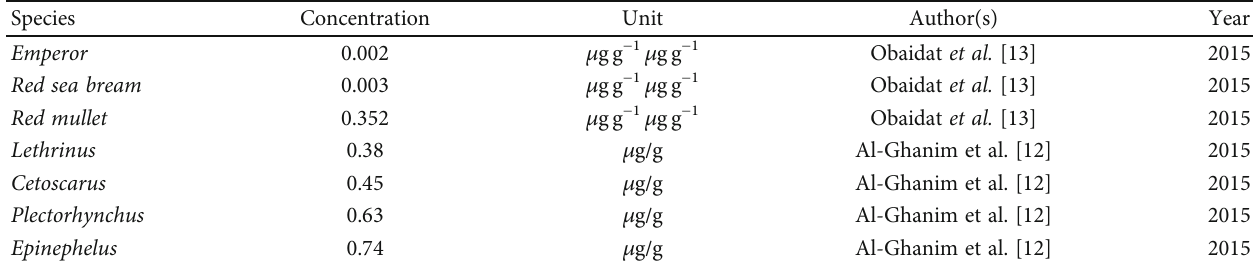
Table 9: Bioaccumulation of arsenic reported from the Red